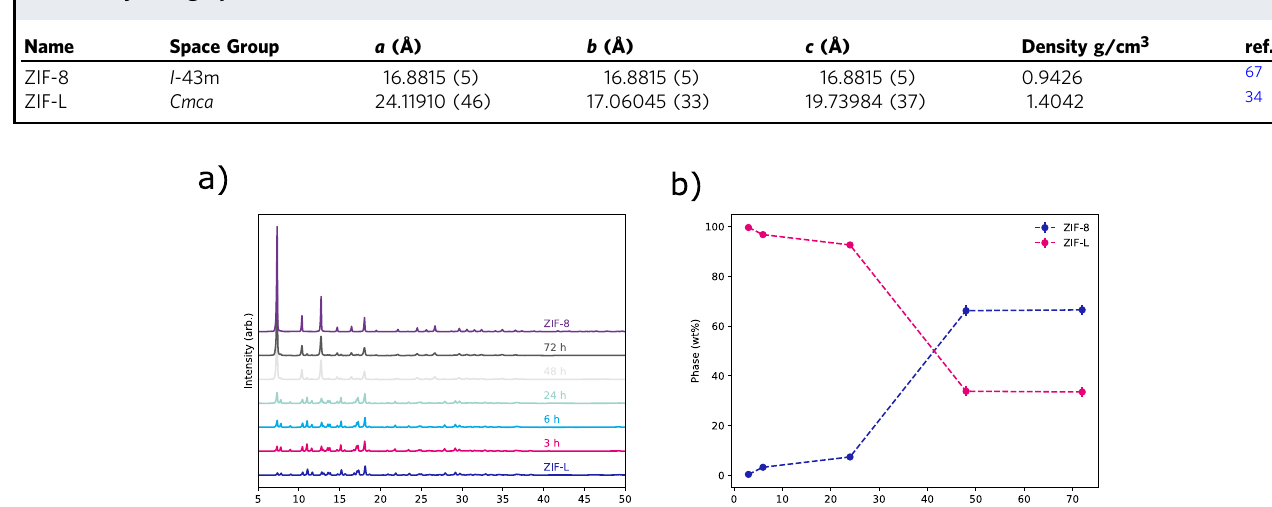
Table 1 Crystallographic information for ZIF-8 and ZIF-L.